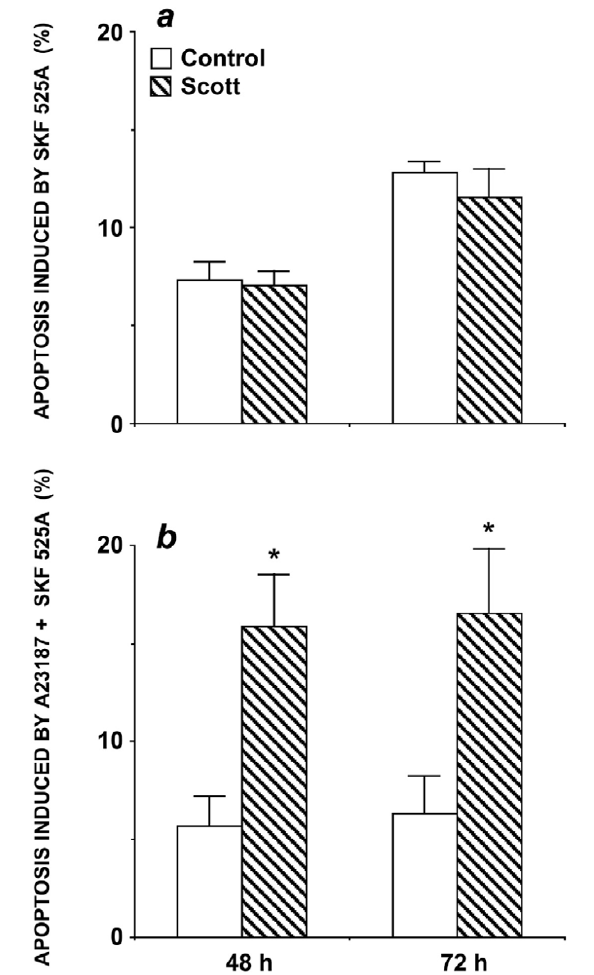
Figure 2 Effect of the cytochrome P450 inhibitor SKF 525A on cell death. Control and Scott B lymphoblasts were treated with SKF 525A (10 µ M) for 48 or 72 h in the absence (a) or in the presence of calcium ionophore A23187 (200 nM) ( b ). The degree of apoptosis was determined by measurement of hypodiploid DNA using propidium iodide (0.1 mg/ml). Values are mean ± SEM of at least 6 independent determinations. * P < 0.05 versus control